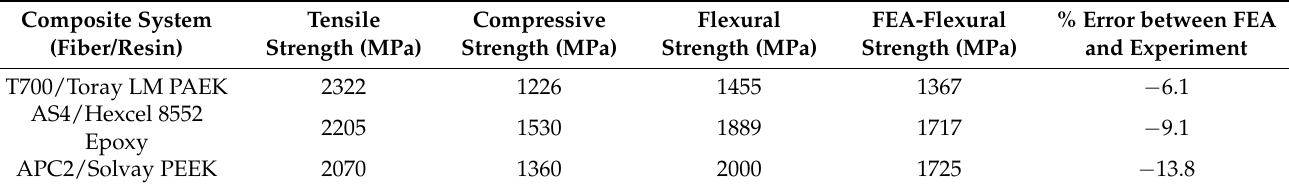
Table 4. Summarized results for three chosen CFRP systems [3–5]. Values in red indicate nearest proximity from flexural strength to either tensile or compressive strength of the material in the fiber direction.